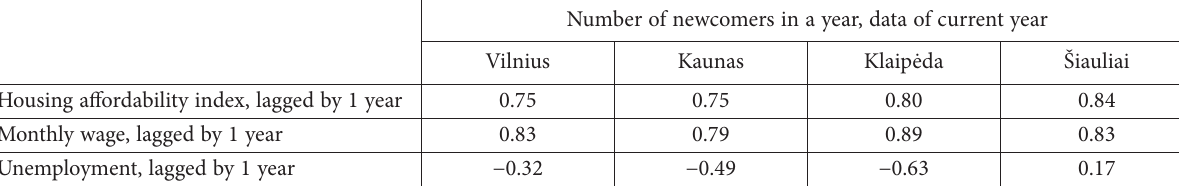
Table 2. Correlation coefficients between the number of newcomers and other variables lagged by 1 year Number of newcomers in a year, data of current